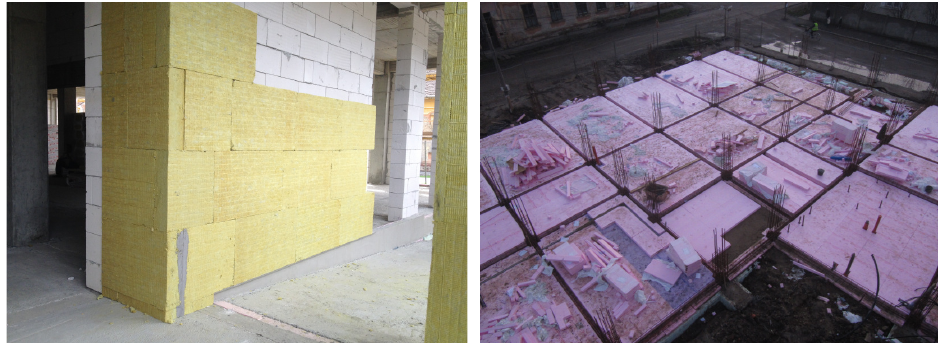
Fig. 4. Thermal insulation of exterior walls Fig. 5. Thermal insulation of ground slab Fig. 1. Overview Fig. 2. School building